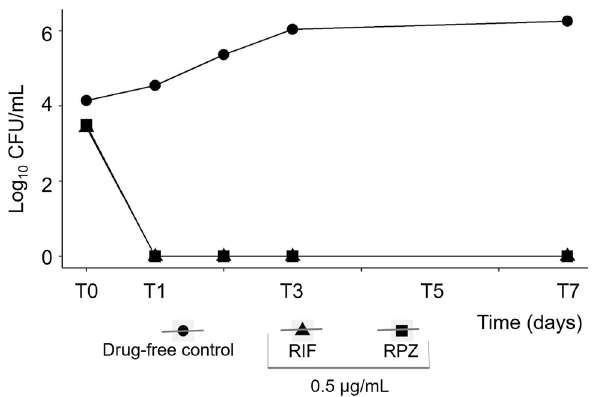
Figure 3. Time-kill curves of the Mtb H37Rv strain when exposed to RPZ and RIF for seven days.